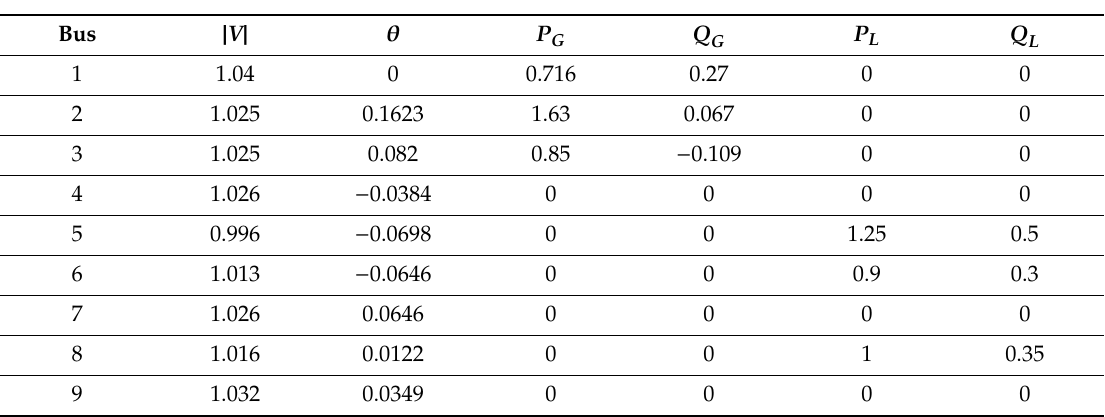
Table A3. Power flow